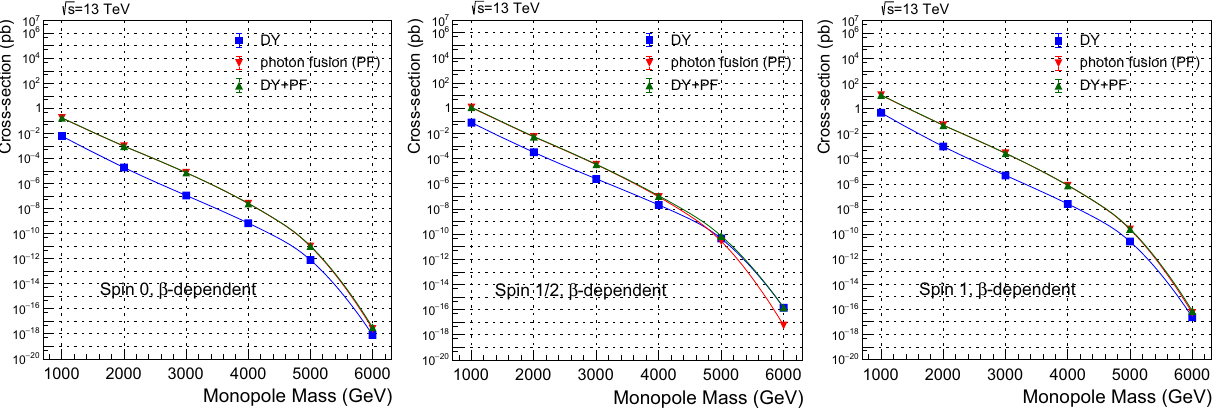
Monopole Mass (GeV) √ Fig. 25 Total cross section at s = 13 TeV for PF, DY and their sum S = 1, the SM values ˜ κ = 0 and κ = 1, respectively, are drawn, while versus the monopole mass. The LUXqed and NNPDF23 PDFs were there is no magnetic moment in the spin-0 used for the PF and the DY process, respectively. For S = 1 / 2 and